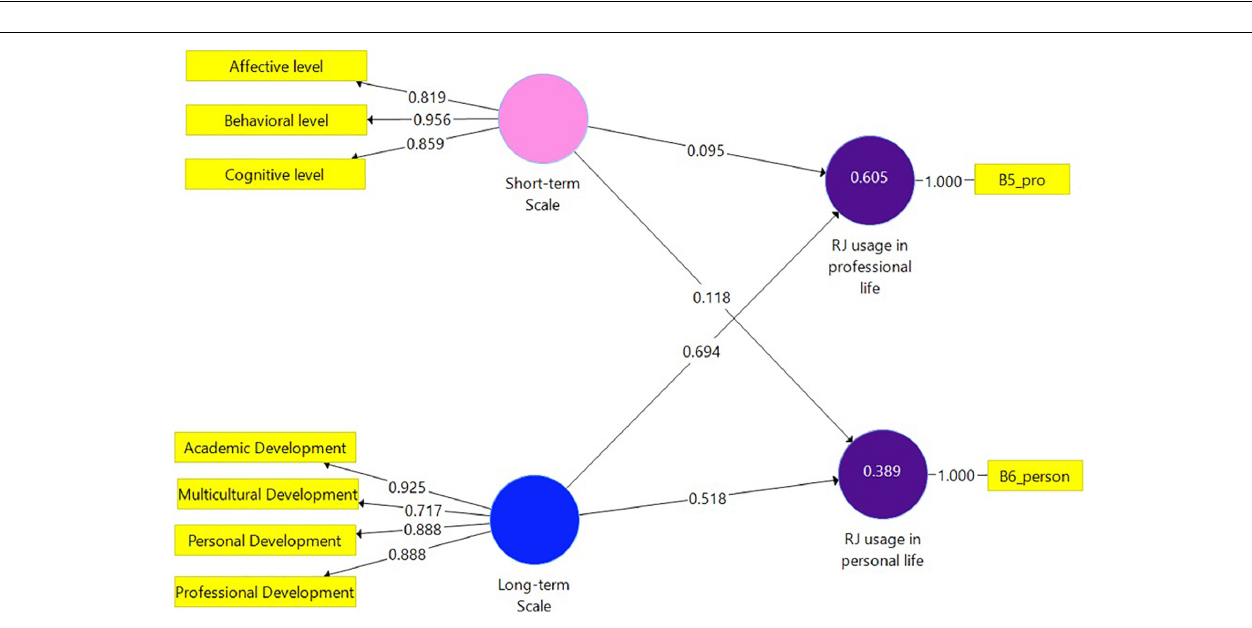
FIGURE 3 | Model 3. Analysis results of the examination of the research hypotheses by SmartPLS (pre-service teachers sample N = 75).